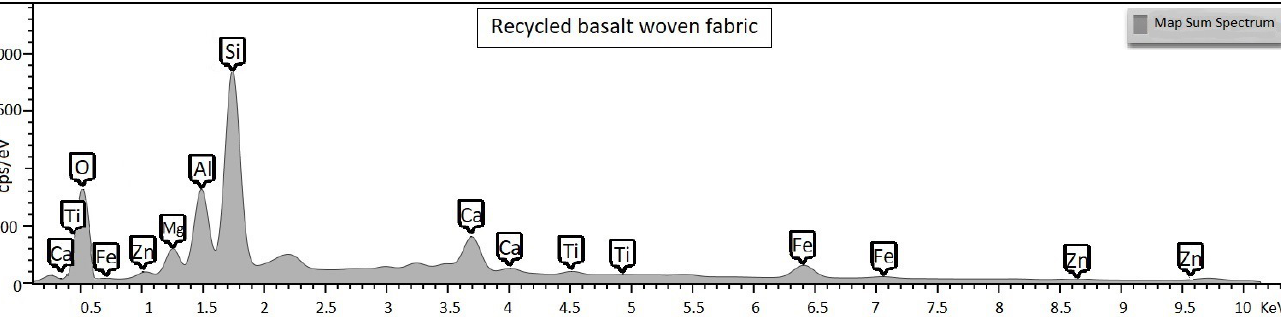
Figure 16. Recycled basalt woven fabric EDS analysis.